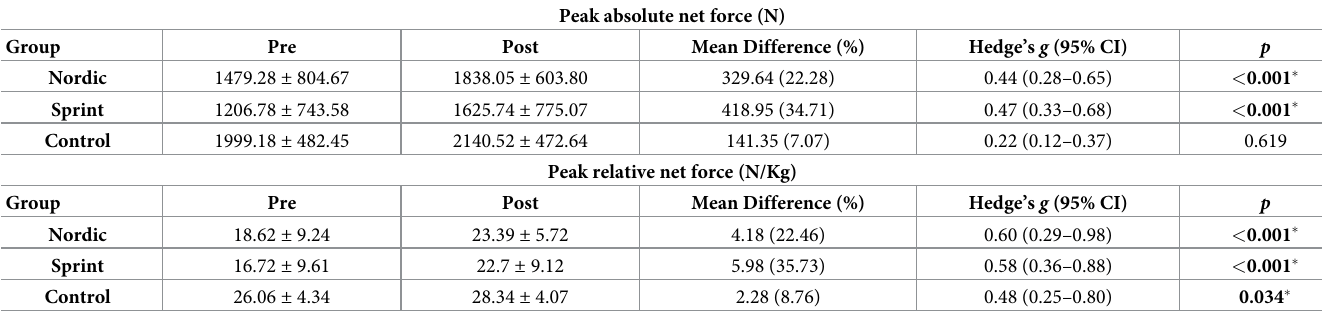
Table 8. Pairwise comparisons of peak net IMTP force for all training